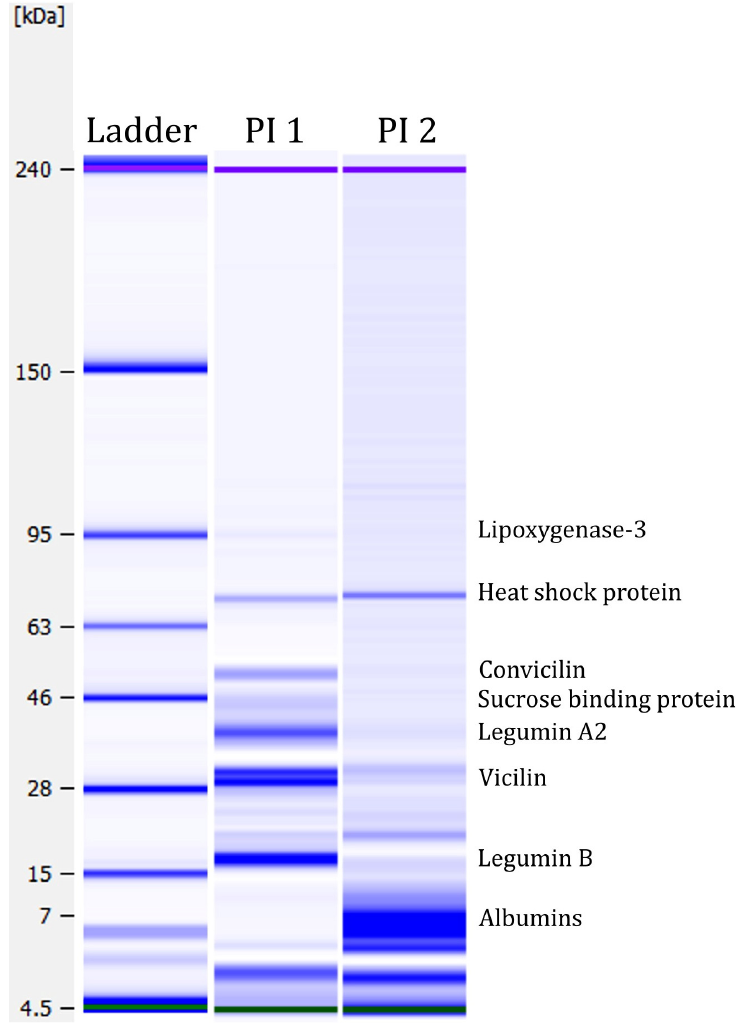
Figure 4. Protein profiles under strong reducing conditions measured with the Agilent Bioanalyzer. Green and purple bands are marker bands. Protein assignment, according to Warsame et al. [87].